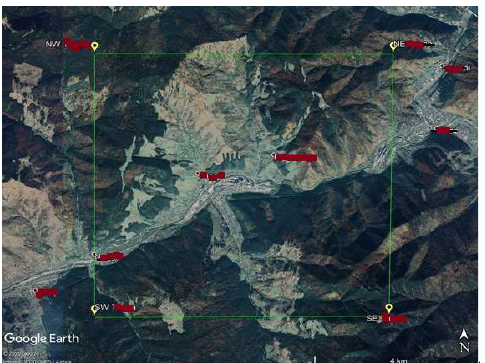
Figure 10. Area of interest for the Cement Plant (Google Earth Pro).